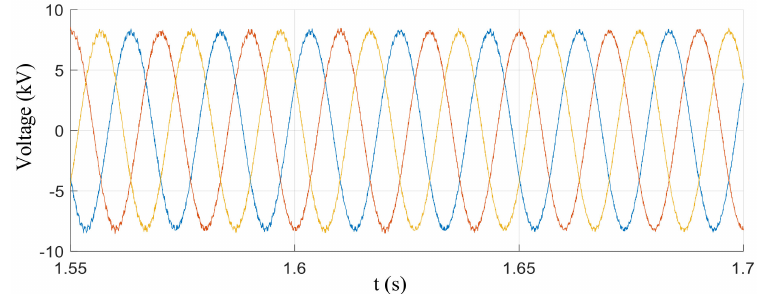
Figure 9. Voltage waveform of the AC bus under the single-pole grounding fault.